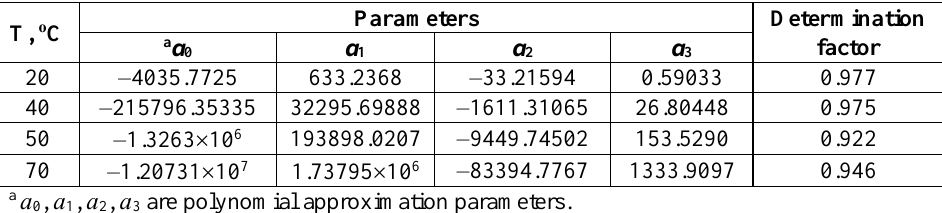
Table 2 . Parameters of cubic polynomial approximation.